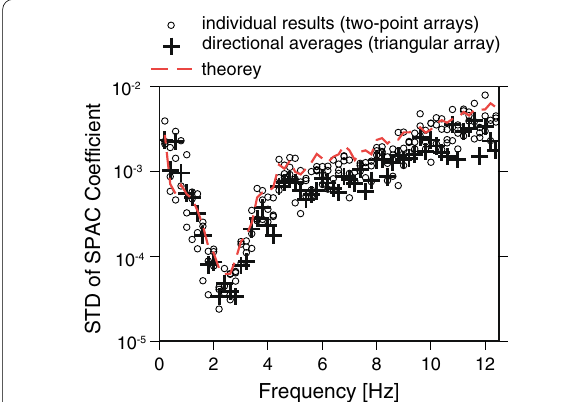
Fig. 5 Standard deviations of the SPAC coefficients for an array with a radius of 0.58 m. Individual analysis results (two-point arrays, circles) and average results (triangular array, crosses) are plotted. The theoretical calculation results (red broken line) are also plotted for comparison